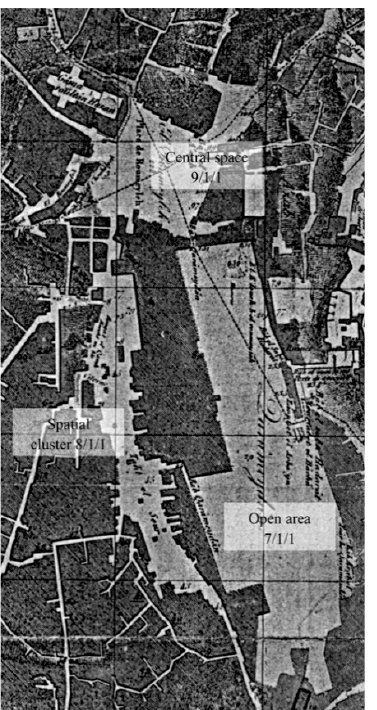
Fig. 4. A relative scale comparison between different sizes of central urban spaces; big, medium, small, and very small spaces, and the biggest open area in historic Cairo coded as